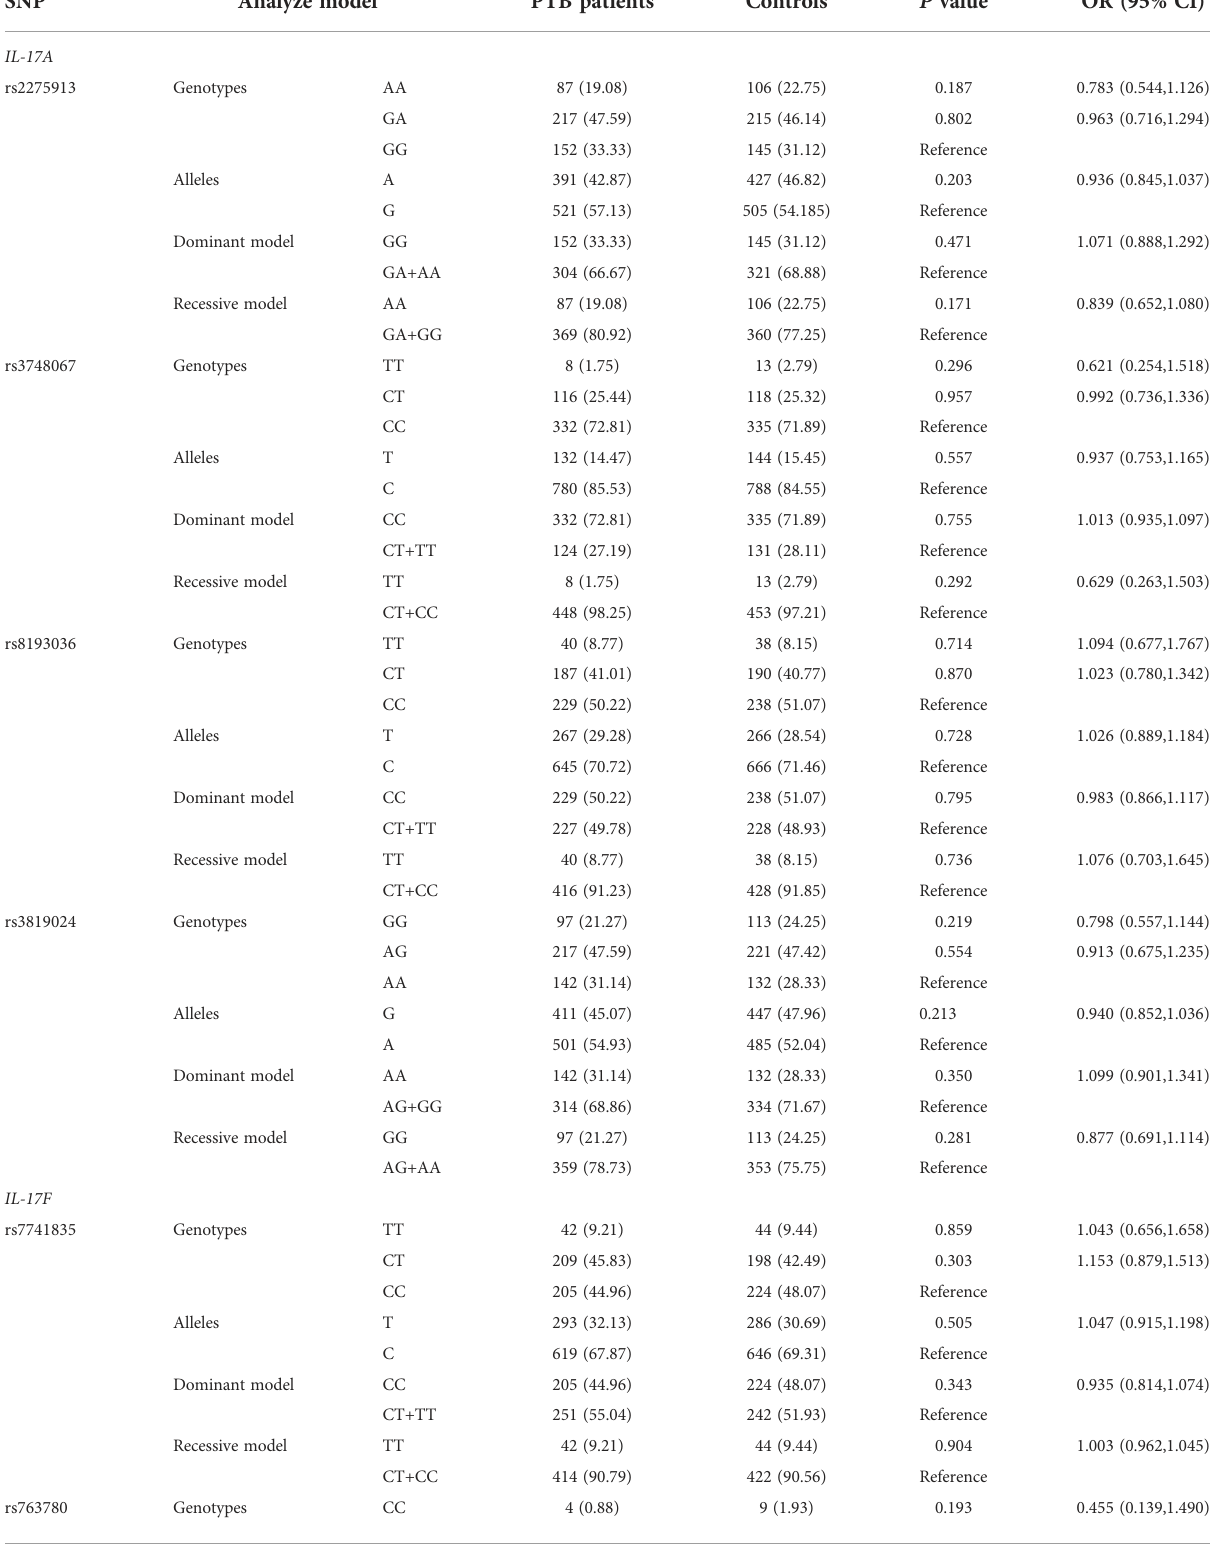
TABLE 1 Association between Th17 pathway genes polymorphisms and PTB